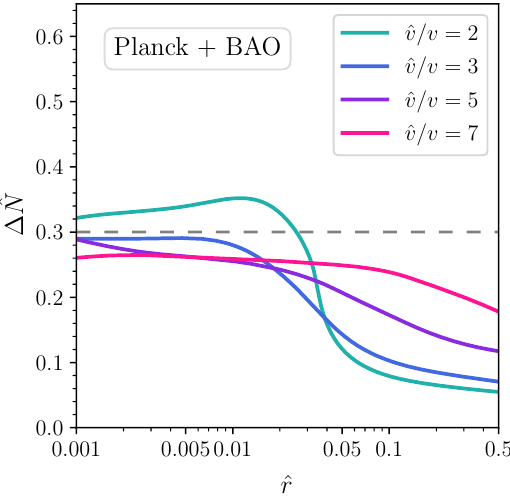
Figure 10. The constraints on the twin parameters obtained using the Planck and BAO datasets, for fixed values of ˆ v/v and using a log prior on ˆ r . All of the parameter space above the lines is excluded at 95% C.L. The dashed gray line indicates the 95% C.L. bound on ∆ N using the same datasets, i.e. Planck 2018 TTTEEE+lowE+lensing+BAO [29]. The simultaneous constraints on all three of the MTH parameters for this choice of datasets are shown in the